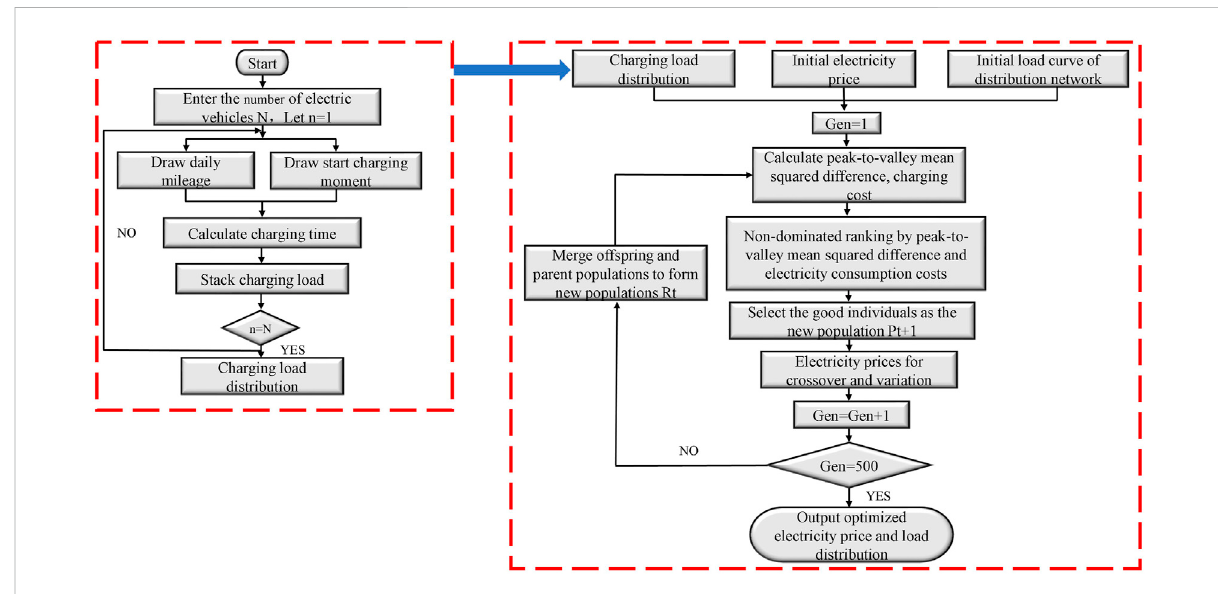
FIGURE 3 Flowchart of the demand response